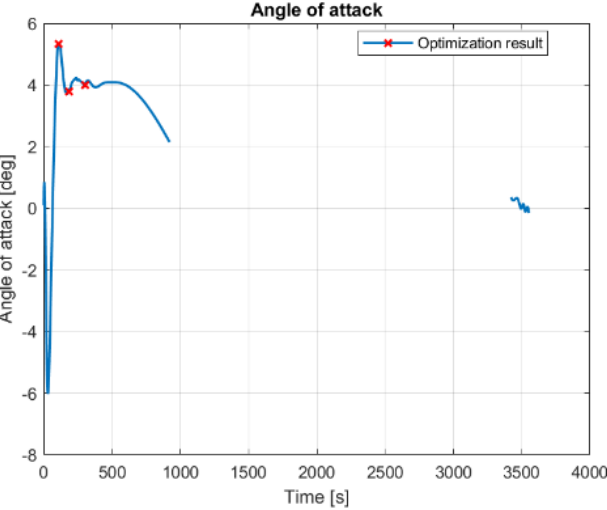
Figure 8. Angle of attack in the optimized trajectory. The red marks indicate the staging or coasting phase.